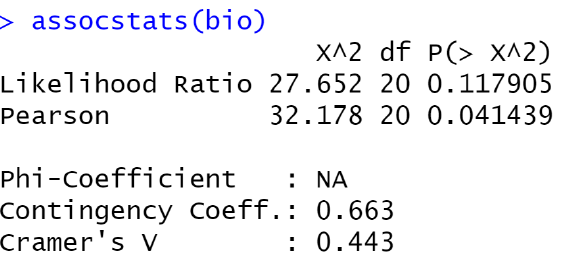
Figure 16. Cramer’s V association test for bioacoustics and general acoustics